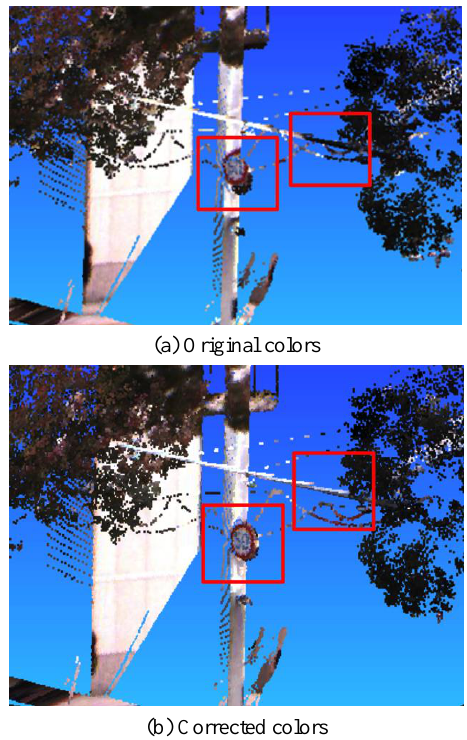
Figure 19. Colors of point-clouds